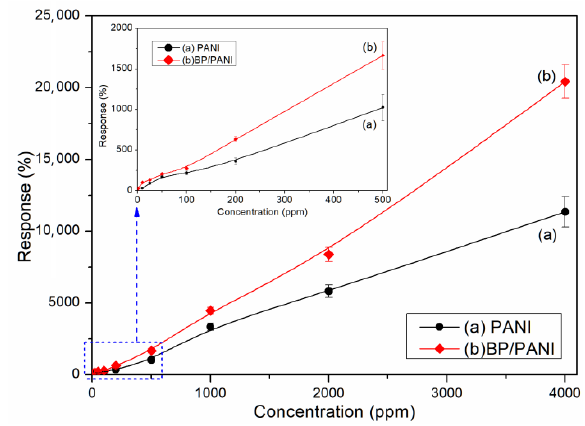
Figure 5. Response values of ( a ) PANI and ( b ) BP/PANI thin film sensors exposed to different concentrations of NH 3 at room temperature.